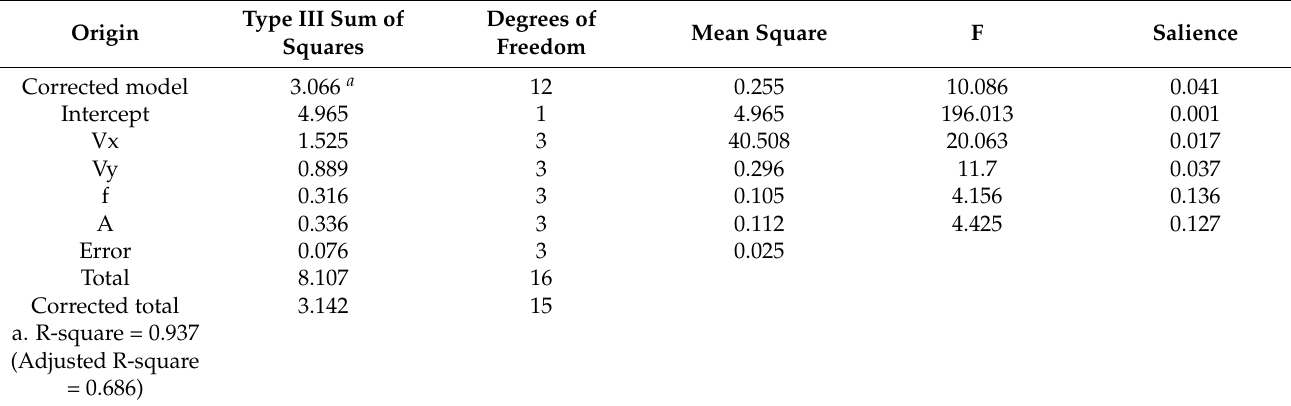
Table 2. Results of orthogonal multivariate